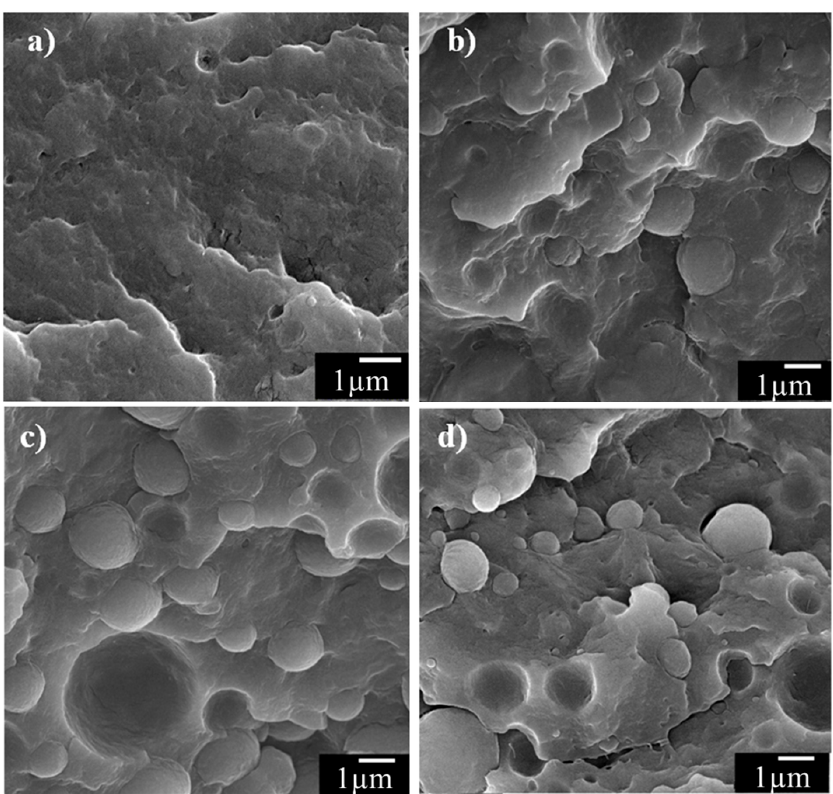
Figure 7. FE-SEM images of the fractured surfaces of CF-reinforced PA6/PP composites with ( a ) 0 wt %, ( b ) 10 wt %, ( c ) 20 wt %, and ( d ) 30 wt % PP without CNTs.